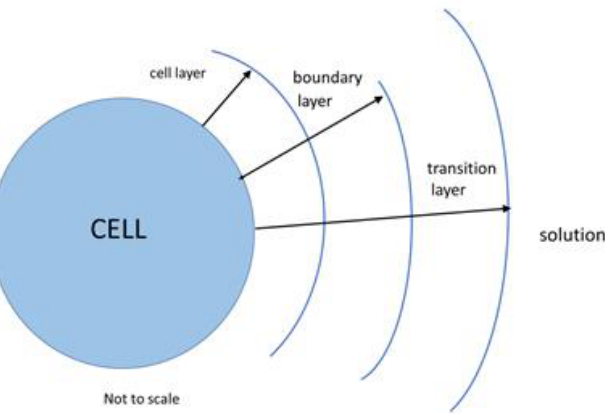
Figure 2. Geometry of the compartments used in the model. The surface of the cell is separated from the solution by three named layers. The “cell layer” contacts the surface of the cell and contains a layer of ions that neutralize the ions on the surface of the cell, the “boundary layer” defines the extent of the cell’s influence on solution bulk flow which is assumed to be zero, and the “transition layer” provides the initial condition for mass transport from bulk solution to the surface of the cell.